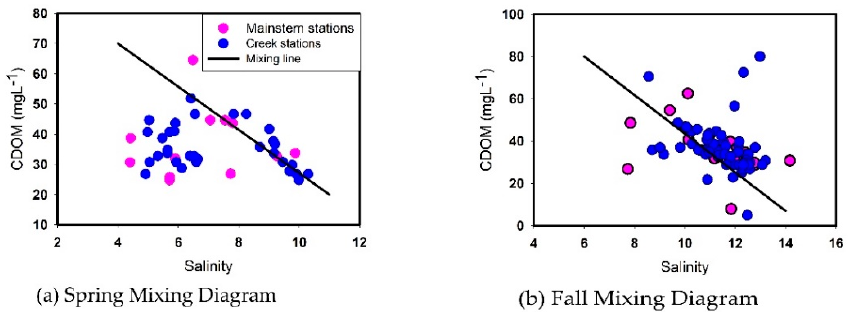
Figure 6. Mixing diagrams for CDOM, ( a ) spring mixing diagram, ( b ) fall mixing diagram .